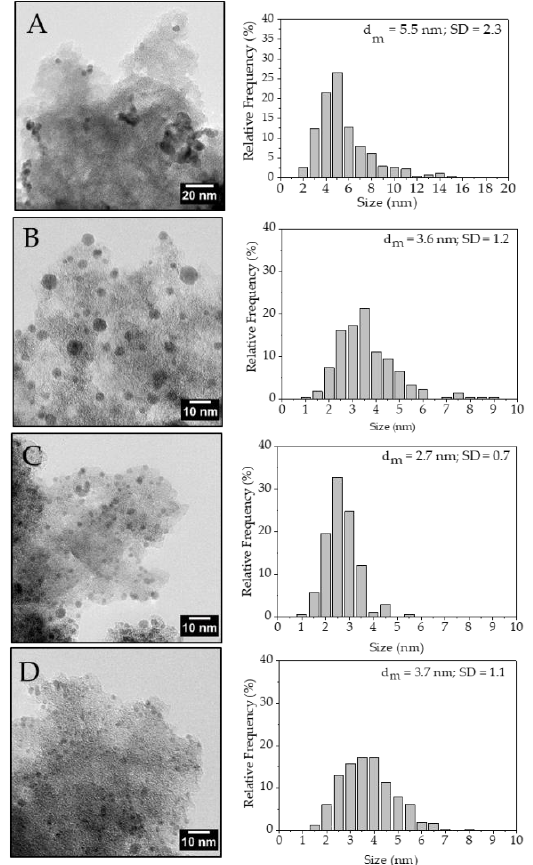
Figure 4. TEM of ( A ) Pd/KB_0.00, ( B ) Pd/KB_0.1, ( C ) Pd/KB_0.3, and ( D ) Pd/KB_1.2 catalysts. Table 4. C 1s, Pd 3d, and O 1s amount obtained from survey spectra of XPS